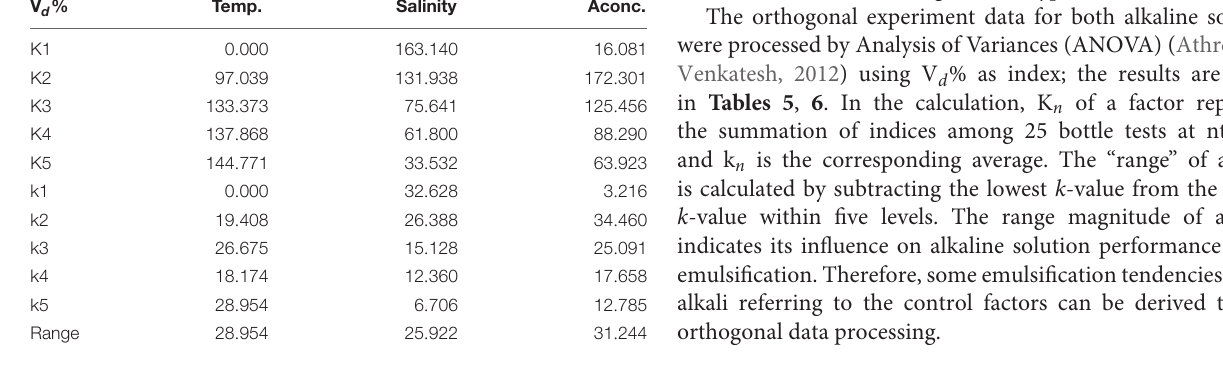
TABLE 6 | Na 2 CO 3 V d % orthogonal data processing. V d % Temp.